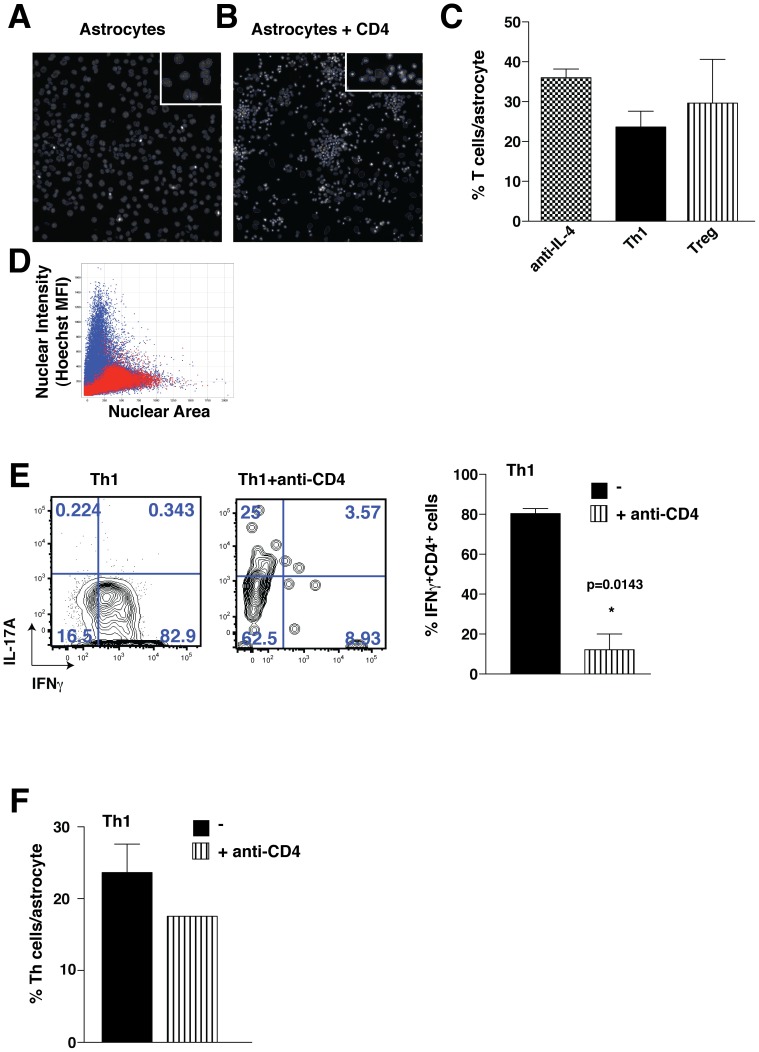
Th1 cell differentiation is promoted by CD4+ T cell activation.CD4+ T cells were cultivated on astrocytes in the presence of 10 µg/mL anti-IL-4 alone (anti-IL-4), with 10 µg/mL anti-IL-4 and 10 ng/mL IL-12 (Th1), or with 10 µg/mL anti-IL-4 and 2.5 ng/mL TGFβ (Treg) for 4 days. Cells were stained with Hoechst and fixed and analyzed using an ArrayScan VTI automated fluorescent microscope. (A) astrocytes alone with nuclei traced (a 20-fold magnification is shown in the small box), (B) astrocytes co-cultured with CD4+ T cells with nuclei traced (a 20-fold magnification is shown in the small box), (C) quantitation of percent of CD4+ T cells associated per astrocyte (mean ± s.e.m.; n = 3), (D) scatter plot showing the cells identified as astrocytes (red) and CD4+ T cells (blue). (E) CD4+ T cells were cultivated on astrocytes in the presence of 10 µg/mL anti-IL-4 and 10 ng/mL IL-12 for 4 days, with or without 10 µg/mL anti-CD4 (GK1.5). Cells were washed, and restimulated with PMA/ionomycin/BFA for 4 h and analyzed by flow cytometry. The histogram represents IFNγ-expressing CD4+ T cells (n = 2, unpaired t-test *p<0.05). (F) CD4+ T cells were cultivated on astrocytes in the presence of 10 µg/mL anti-IL-4 and with 10 ng/mL IL-12 for 4 days, with or without 10 µg/mL anti-CD4 (GK1.5). Cells were stained with Hoechst and fixed and analyzed with an ArrayScan VTI automated fluorescent microscope. Bars represent mean ± s.e.m. (n = 3).